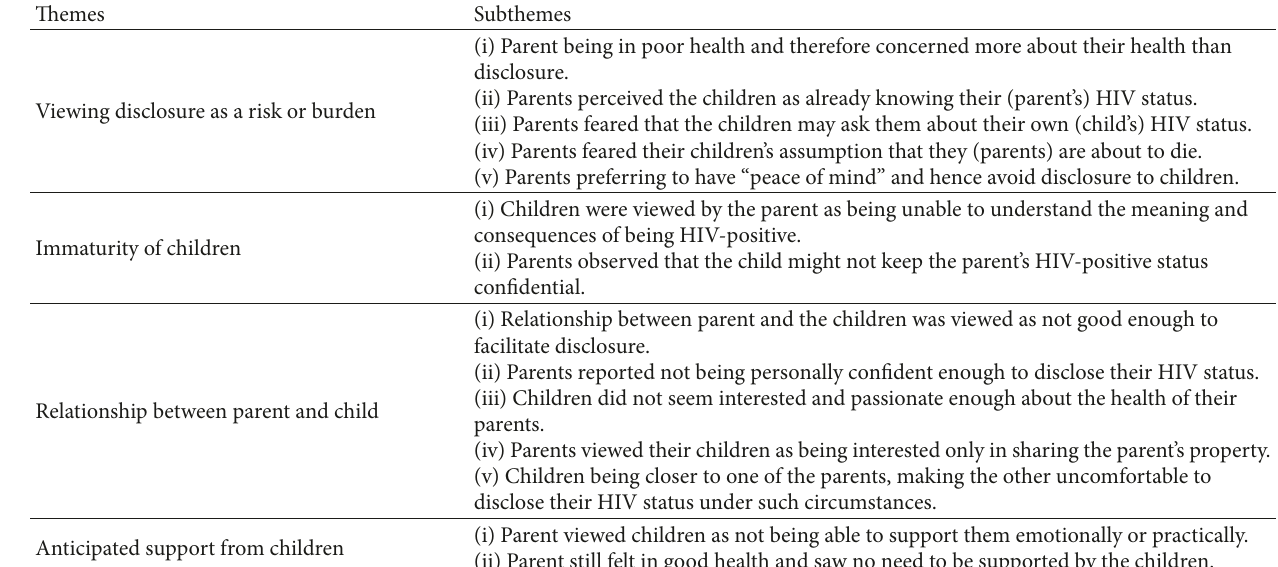
Table 2: Barriers/hindrances to disclosure as presented by parents who did not disclose HIV serostatus to their children. Themes